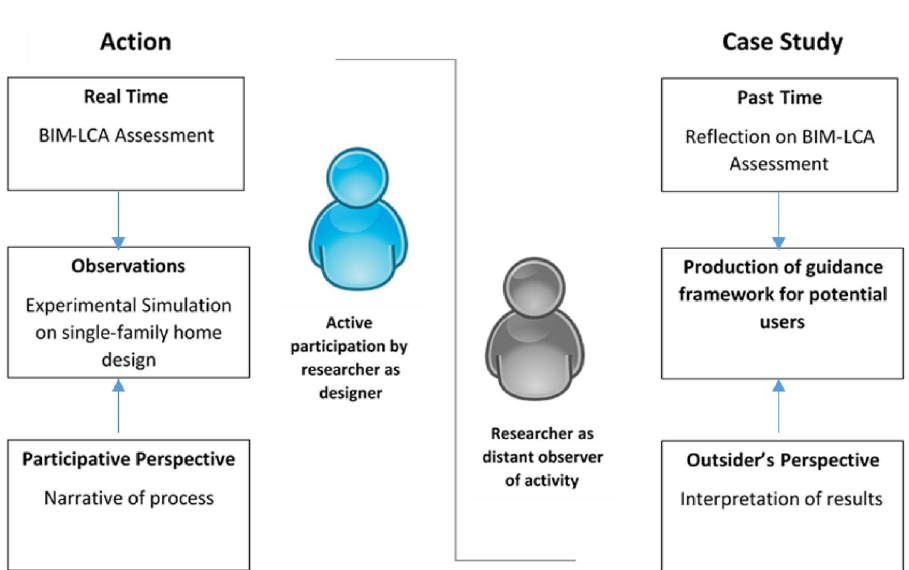
Fig. 3 Action case study model adopted for the project. Adapted from Halecker